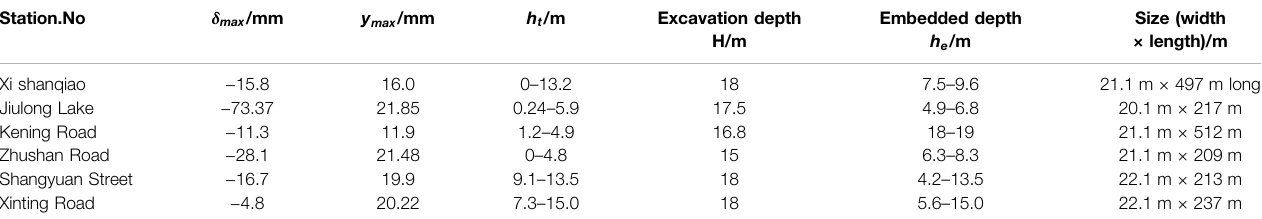
TABLE 1 | Monitoring data of deep foundation pit of soil-rock composite metro in Nanjing stations. Station.No